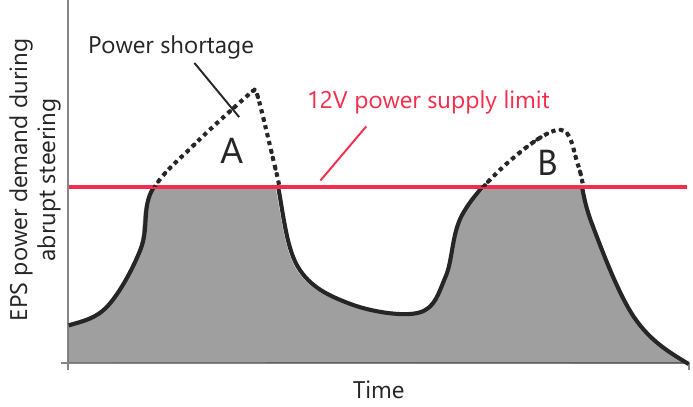
Figure 2. Electric power consumption of EPS during abrupt steering.